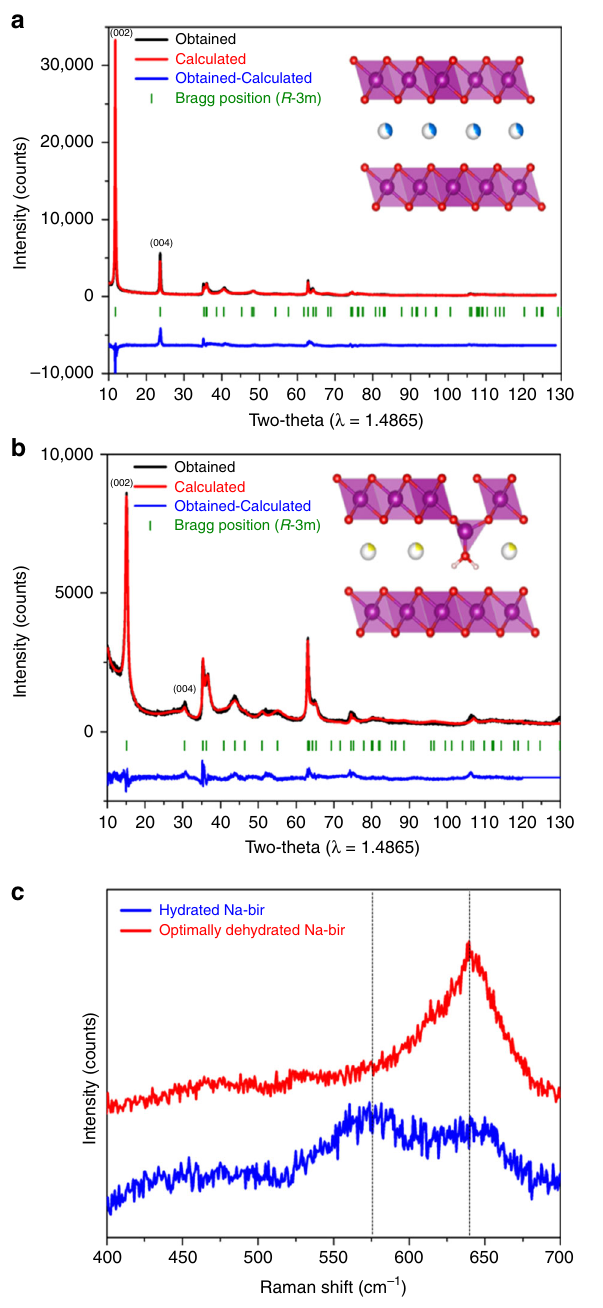
Fig. 1 Structural characterizations of hydrated and partially dehydrated Na-birs. Rietveld-re fi ned XRD pattern of a hydrated Na-bir and b partially dehydrated Na-bir. c Raman spectra of hydrated Na-bir and partially dehydrated Na-bir. TEM images of hydrated Na-bir: d low magni fi cation bright fi eld image (scale bar = 500 nm); e , f high-resolution bright fi eld image (scale bar = 5 nm), and g fast Fourier transform (FFT) pattern. TEM images of partially dehydrated Na-bir: h low magni fi cation bright fi eld image (scale bar = 500 nm); i , j high-resolution bright fi eld image (scale bar = 5 nm); k , l FFT of the regions enclosed in the red and yellow rectangles in i , and m , n their respective inverse